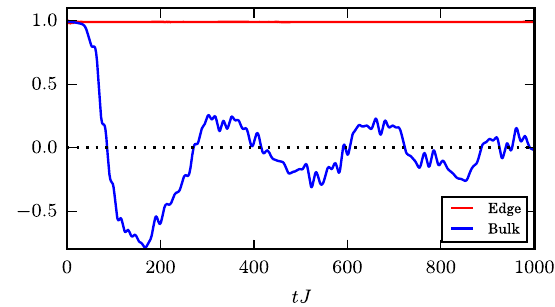
FIG. 3. The decay of a MZM at low energies, as obtained by TEBD for systems of length L ¼ 40 , which shows that a long- lived MZM persists even in a much larger system. Red: Decay of the strong zero mode Green ’ s function h Ψ j γ A 1 ð t Þ γ A 1 ð 0 Þj Ψ i for an initial state j Ψ i containing a single quasiparticle close to the left edge (i.e., − γ B 3 γ A 4 ¼ − 1 and γ B i γ A i ¼ 1 for i ≠ 3 ), for þ 1 L ¼ 40 and h=J ¼ h =J ¼ 0 . 075 . This is equivalent in the 2 corresponding transverse-field Ising chain to the spin correlation h Ψ j σ z 1 ð t Þ σ z 1 ð 0 Þj Ψ i . Blue: Decay of the bulk spin